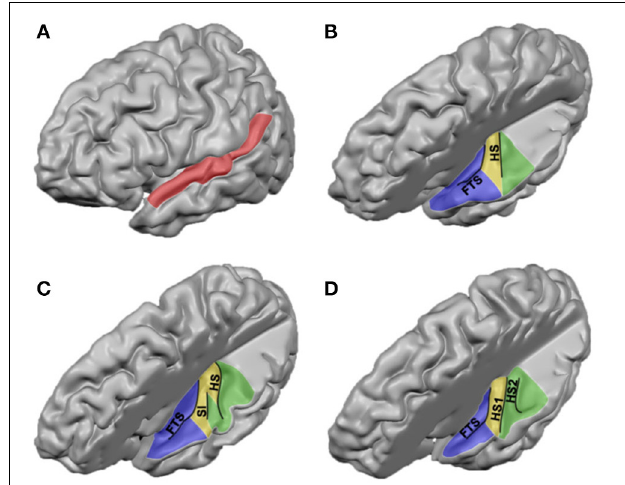
FIGURE 1 | Anatomical landmarks on the human supratemporal plane. (A) Lateral view of the left hemisphere, with STG indicated in red. (B–D) Top view of left supratemporal plane, after removal of a large part of the parietal cortex. PP, HG, and PT are indicated in blue, yellow, and green, respectively. Major sulci are outlined in black (FTS, first transverse sulcus; SI, sulcus intermediate; HS, Heschl’s sulcus; HS1, first Heschl’s sulcus; HS2, second Heschl’s sulcus). Panels include hemispheres with one HG, an incomplete separation of HG, and two HG in (B–D) ,